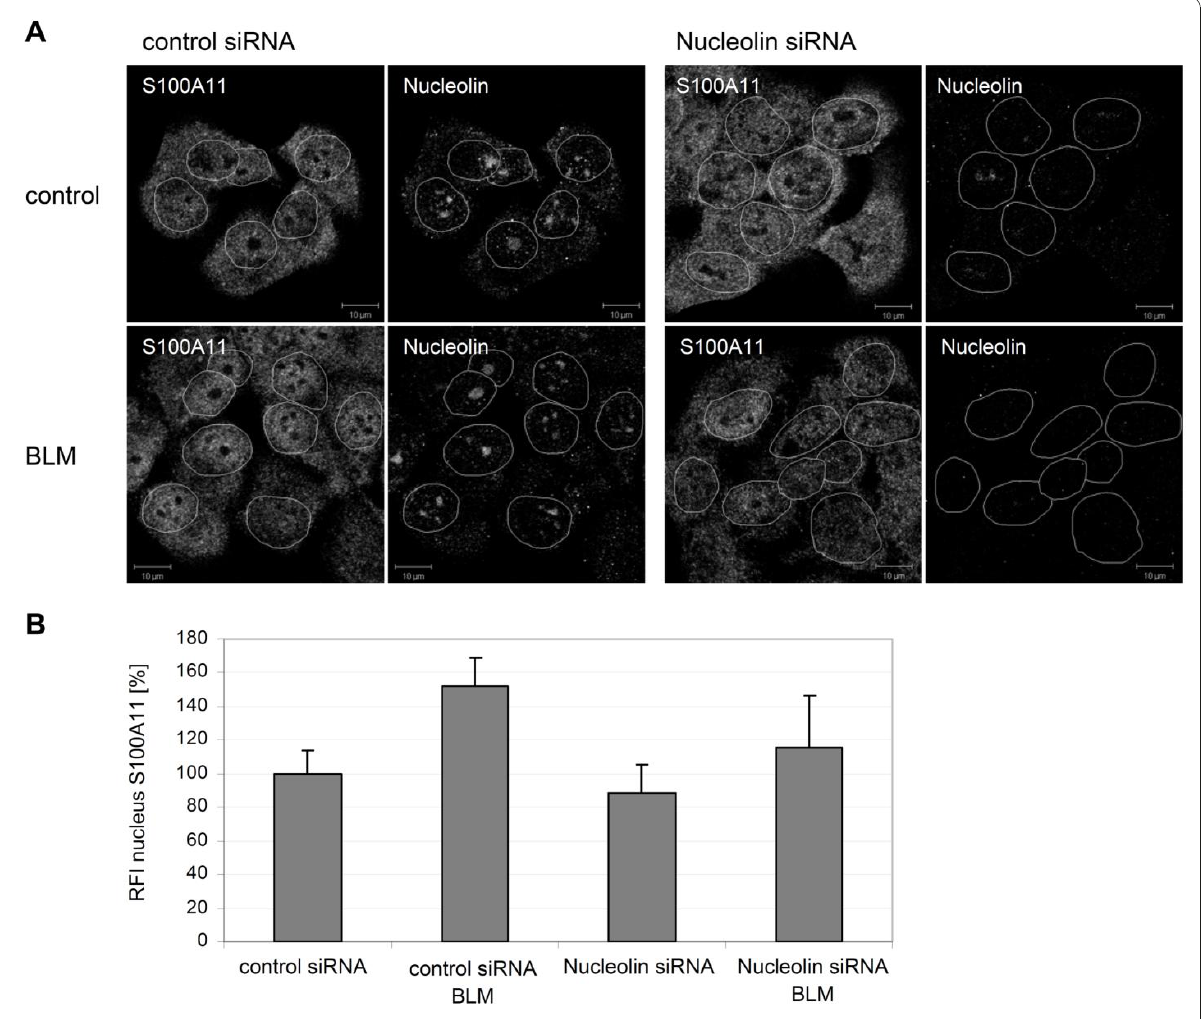
Figure 4 Down-regulation of nucleolin interferes with translocation of endogenous S100A11 . (A) HaCaT cells treated with BLM for 30 min or control cells were transfected with specific siRNA for depletion of nucleolin (nucleolin siRNA) or, as a control, unspecific nonsilencing siRNA (control siRNA), respectively. Cells were analyzed by laser scanning confocal microscopy using specific antibodies against S100A11 and nucleolin. (B) Quantification of the nuclear localization of endogenous S100A11 in human HaCaT keratinocytes transfected with a specific nucleolin siRNA or, as control, an unspecific control siRNA. Transfected cells were treated with BLM for 30 min and the relative fluorescence intensity (RFI) of the S100A11 signal in selected areas (2 μ m diameter) was assessed in several nuclear areas by a specific anti-S100A11 antibody as well as in untreated cells. At least 25 cells were analyzed for each condition. Data are displayed as mean values (±SD). The average of the S100A11 fluorescence intensities measured in untreated control cells transfected with control siRNA was set as